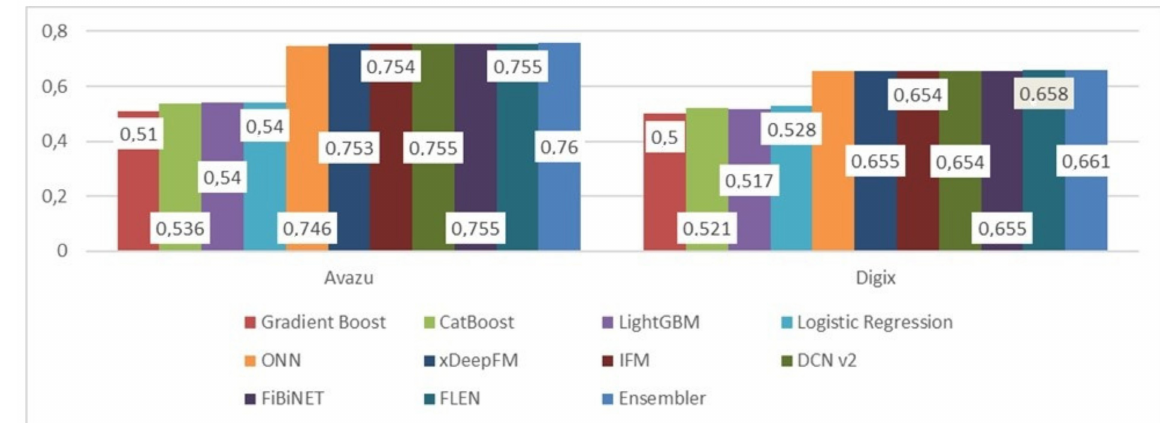
Figure 1. AUC scores for models regarding Avazu and Digix dataset.